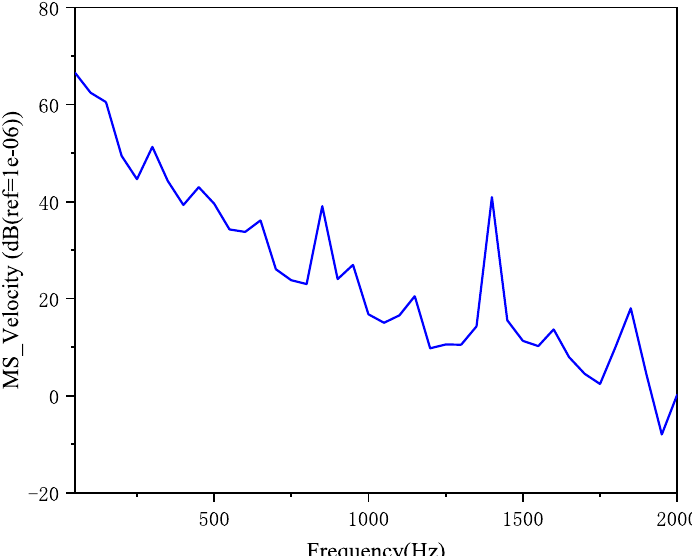
Figure 11. Mean square vibration characteristics.